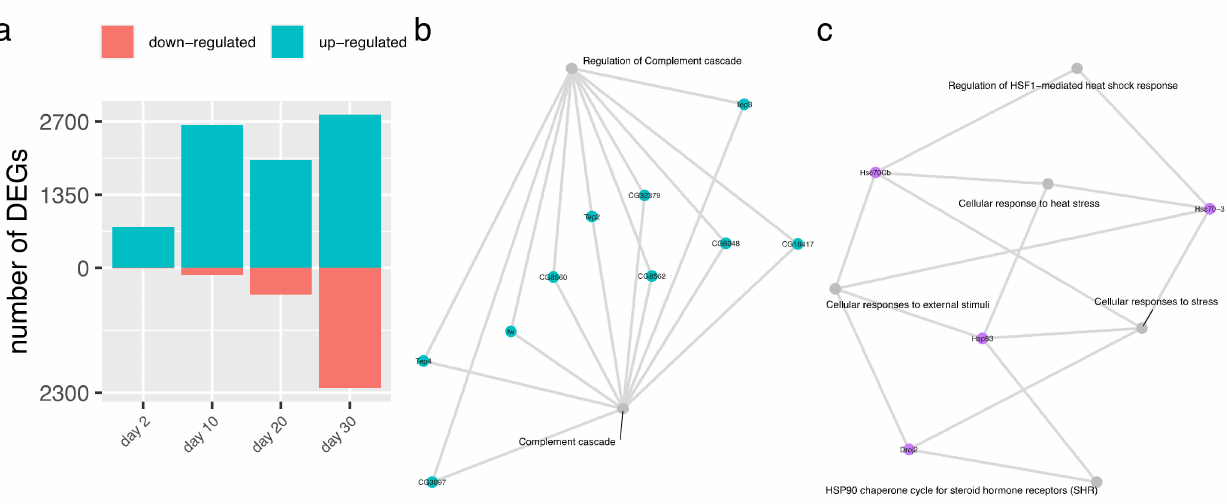
Figure 6. Time course analysis of the systemic response to DMelNV. ( a ) Number of differentially expressed genes at each time point. ( b ) Enriched pathways related to immune defense in up-regulated genes at 20 and 30 days post-eclosion. ( c ) Enriched pathways in genes which expression correlate to DMelNV RNA accumulation but are down-regulated at 20 and/or 30 days post-eclosion. Each pathway is represented by a grey node connected to genes found to be differentially